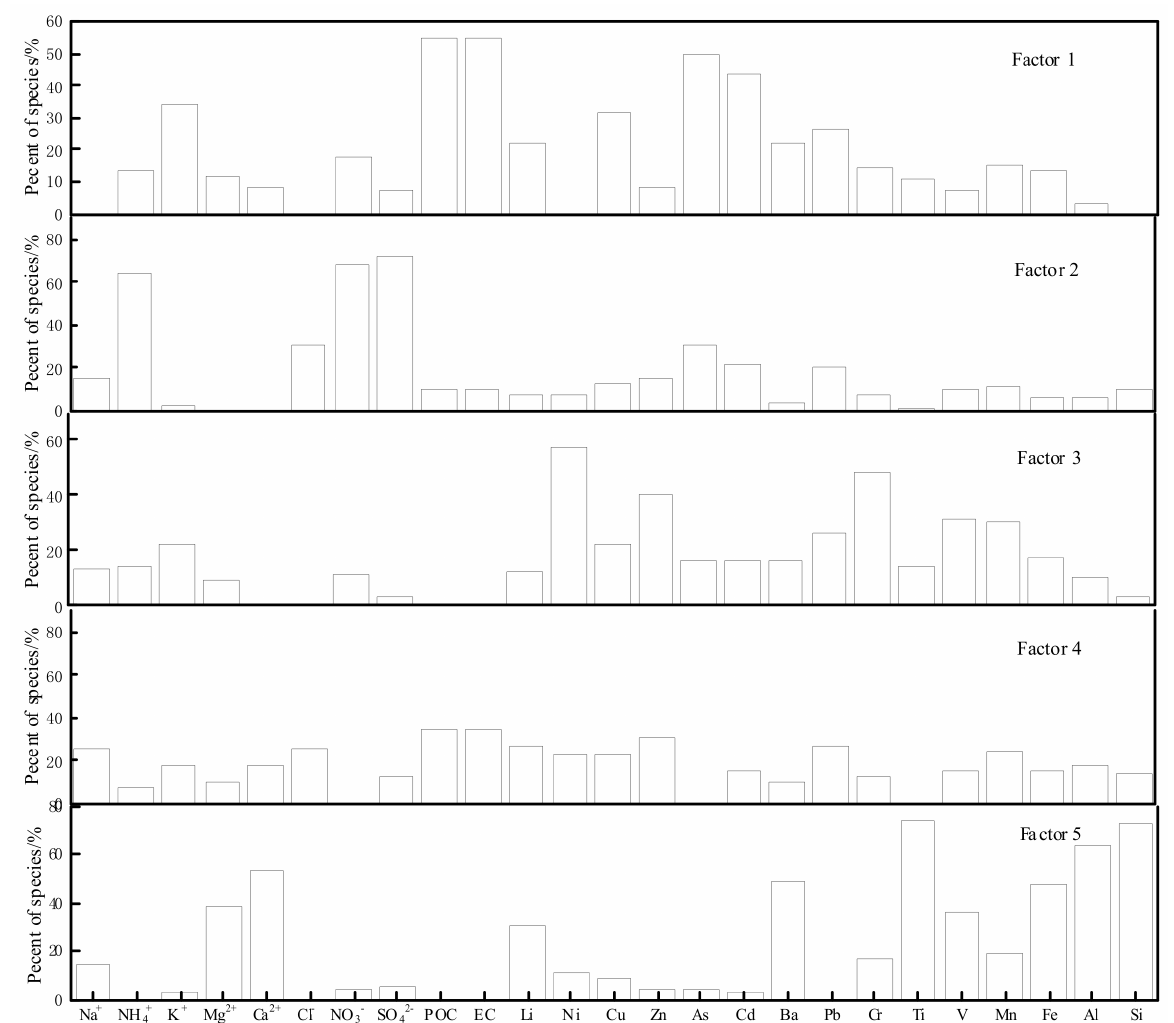
Figure 8. Source analysis of PM 2.5 in autumn and winter in